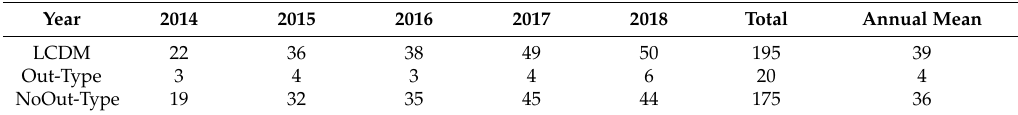
Table 1. The number of local convections in Dabie Mountains during 2014–2018 in the warm seasons (from April to